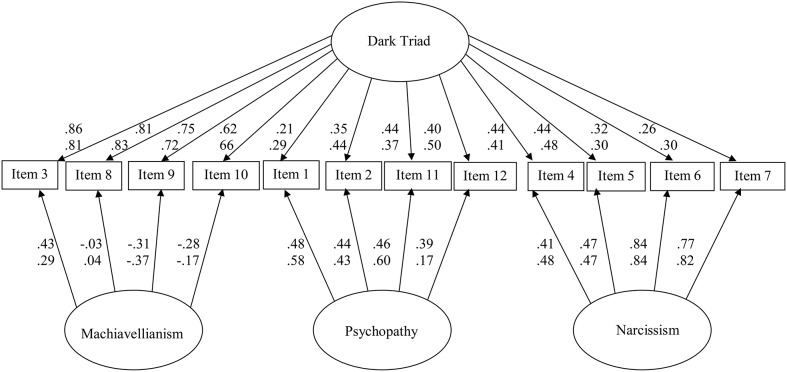
Bifactor model for the Polish translation of the Dirty Dozen from Study 1 (upper row of numbers) and Study 4 (lower row of numbers). Study 1: N = 304; χ(42)2 = 117.65, p < 0.01, χ2/df = 2.80, CFI = 0.94, NFI = 0.91, RMSEA = 0.08, 90% CI [0.06,0.09]). Study 4: N = 634; χ(42)2 = 84.14, p < 0.01, χ2/df = 2.00, CFI = 0.99, NFI = 0.97, RMSEA = 0.04, 90% CI [0.03,0.05]).